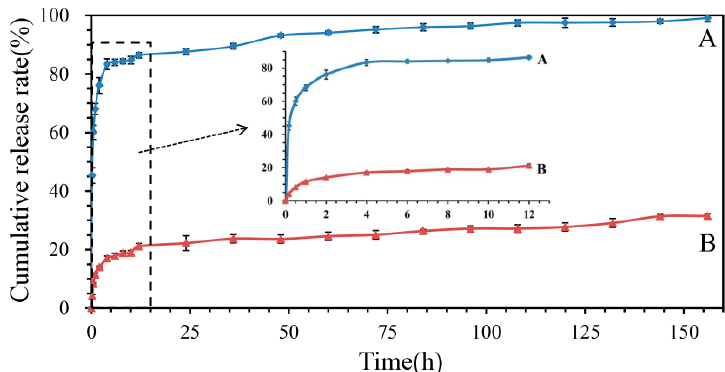
Figure 7. Cumulative release curves of emodin from nanofibers and raw emodin. A: nanofibers containing emodin, B: raw emodin. The insert profiles show the release behavior of nanofibers and raw emodin during the initial 12 h.